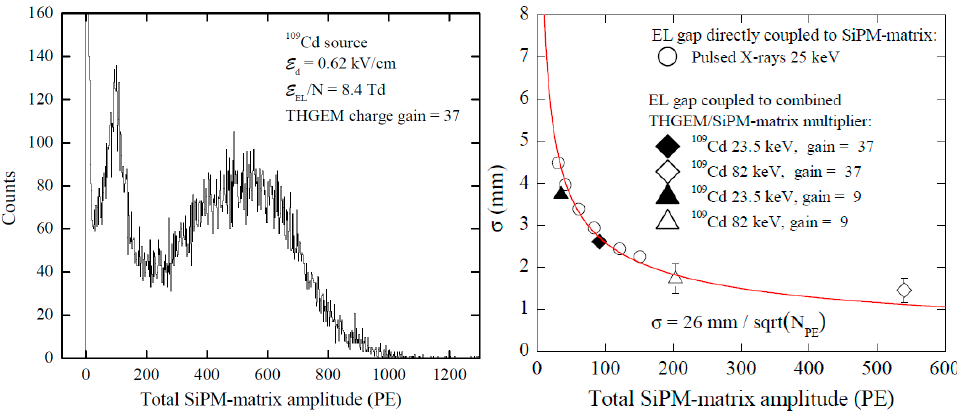
Figure 23. Total SiPM-matrix amplitude spectrum for gamma-rays of 109 Cd source (left) and its position resolution (right), in two-phase Ar detector with EL gap and combined THGEM/SiPM-matrix multiplier, shown in Figure 22 [12]. The THGEM charge gain was 37. The two characteristic peaks of low (22–25 keV) and high energy (60–70 and 88 keV) lines of 109 Cd source on W substrate are well separated in the amplitude spectrum. The position resolution (standard deviation) is shown as a function of the total number of photoelectrons recorded by the SiPM matrix. The curve is the fit by inverse root function.